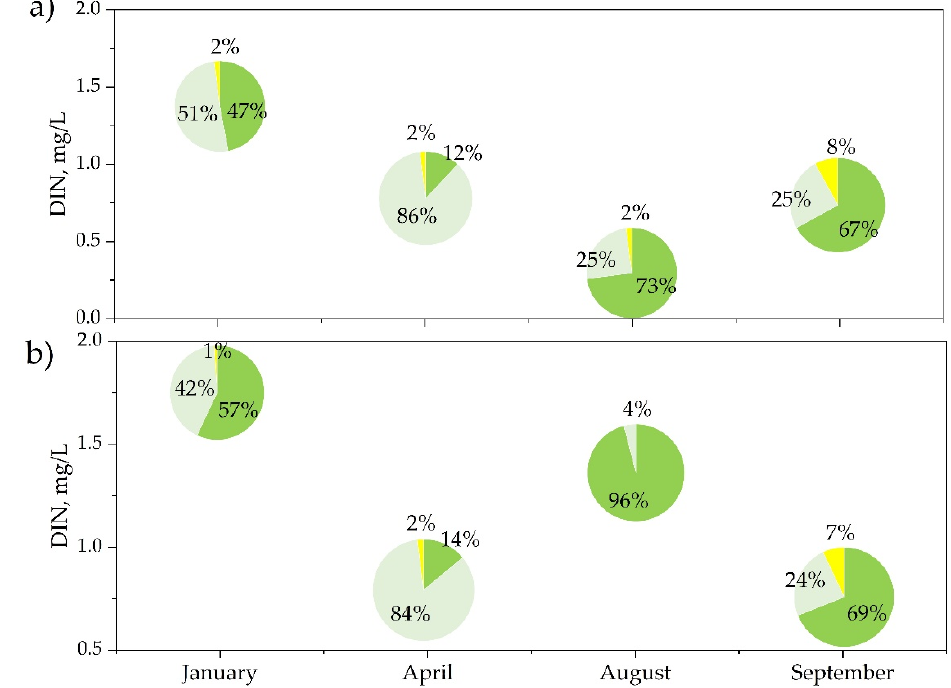
Figure 6. Percentages of NH 4+ -N (green), NO 3- -N (light green), and NO 2- -N (yellow) in total DIN concentrations in the water from three sites at Lake Bulan; ( a ) surface and ( b ) bottom layer (7 m depth).